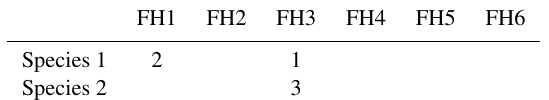
Table 6. This is how the above example would appear in the ma- trix downloaded from the Arctic Traits Database. In the download matrix format species are rows, trait categories are columns and the fuzzy codes are the values. Due to the database structure zero codes (“0”) are only displayed when they are backed up by a specific ref- erence (e.g., for the trait category LH3/tube dwelling: “No species within the family Polynoidae is tubiculous”).